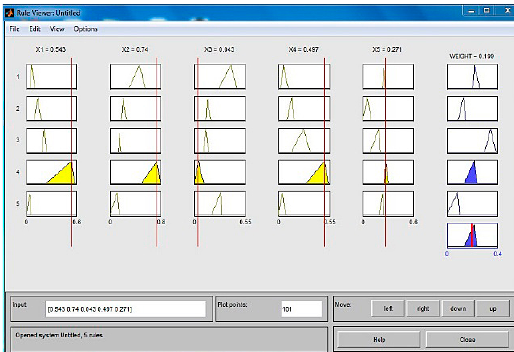
fig. 7. output function a